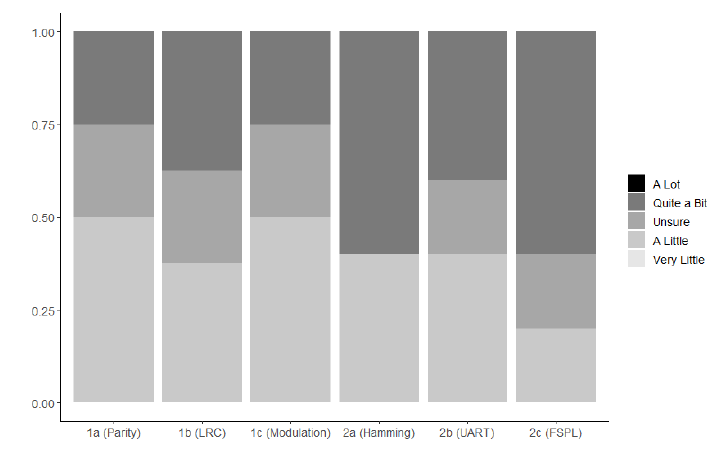
Figure 6. Survey results rating puzzle